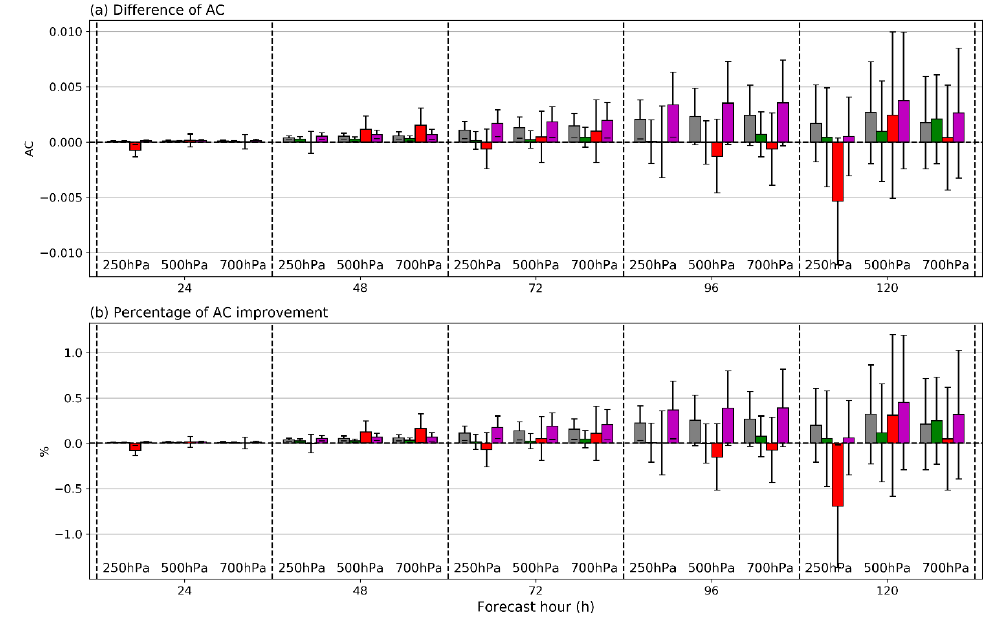
Figure 7. The ( a ) mean and ( b ) normalized difference of AC of 250 hPa, 500 hPa, and 700 hPa geopotential height forecast up to 120–h forecast hours between the latency_20m and control runs. Grey, green, red, and magenta boxes indicate the results over the Global, Northern Hemisphere, Tropic, and Southern Hemispheres, respectively. Vertical bars representing 95% confidence level of the uncertainty are overlaid.